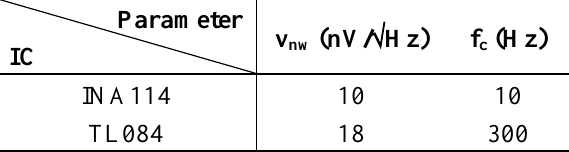
Table 13. Noise specifications for the circuits INA114 and TL084.